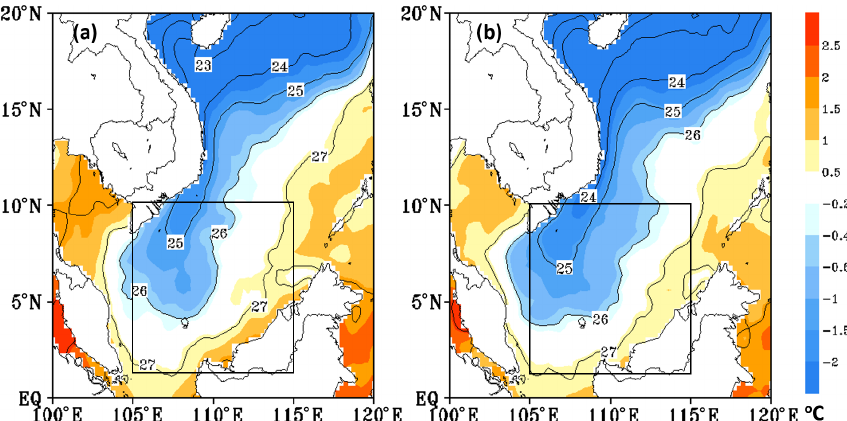
Figure 10. Same as Fig. 9 but with a smaller domain and for a composite of EMP samples: (a) SCS-CT without CENS, (b) SCS-CT with